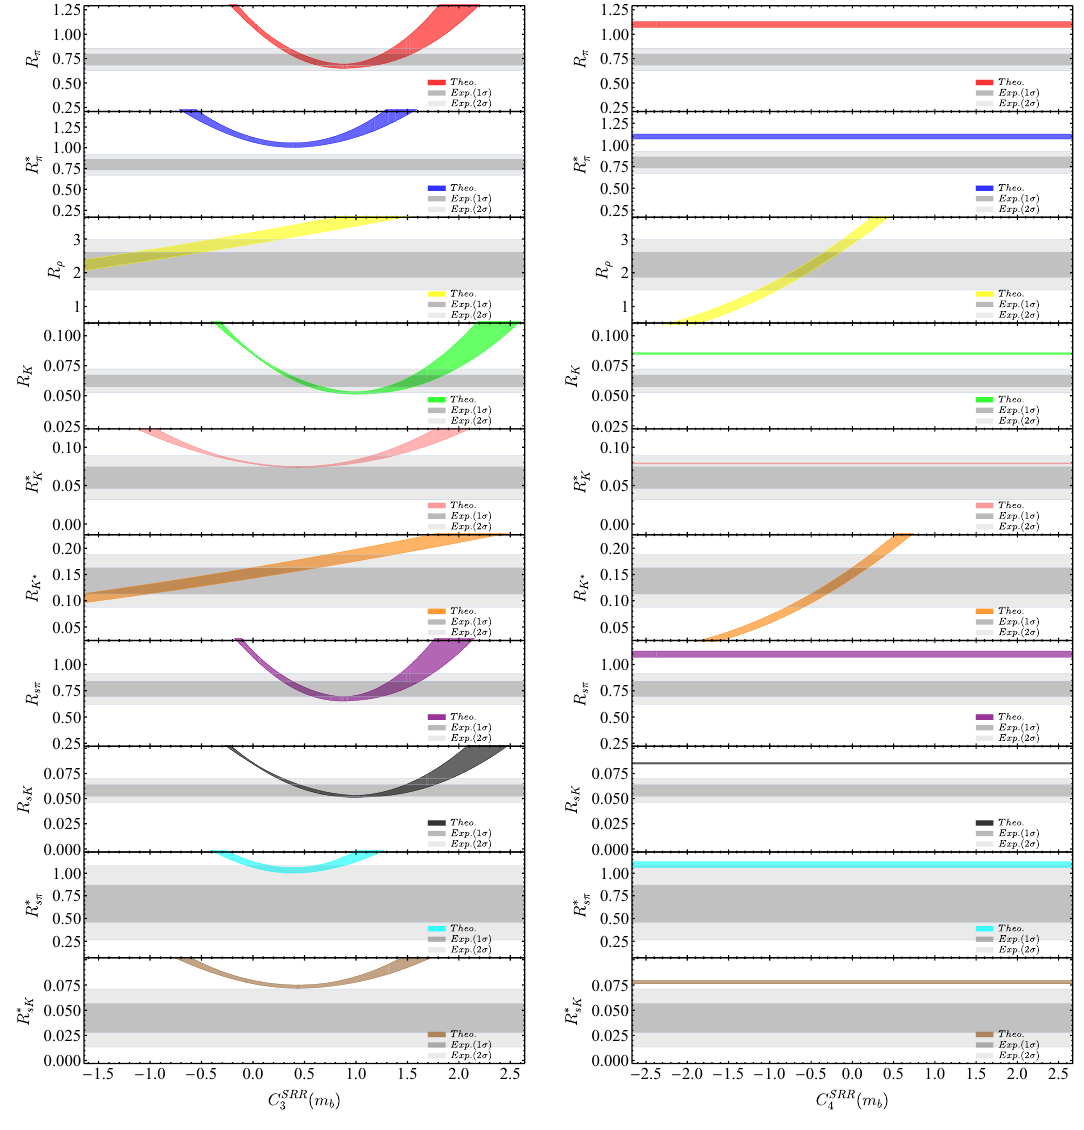
Figure 9 . Same as in figure 5 but for the NP Wilson coefficients C SRR